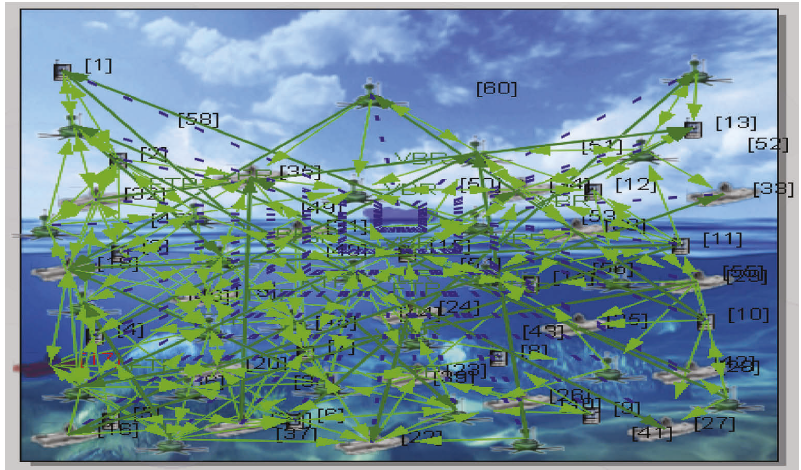
Figure 5: Runtime proposed scenario of underwater wireless communication with various nodes in X-Y